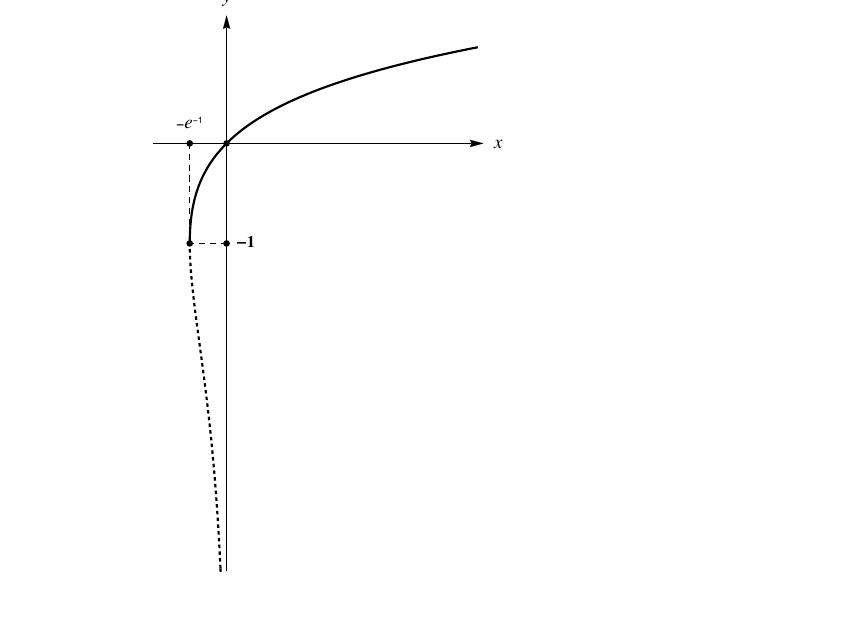
Figure 3. The two branches of W with W − 1